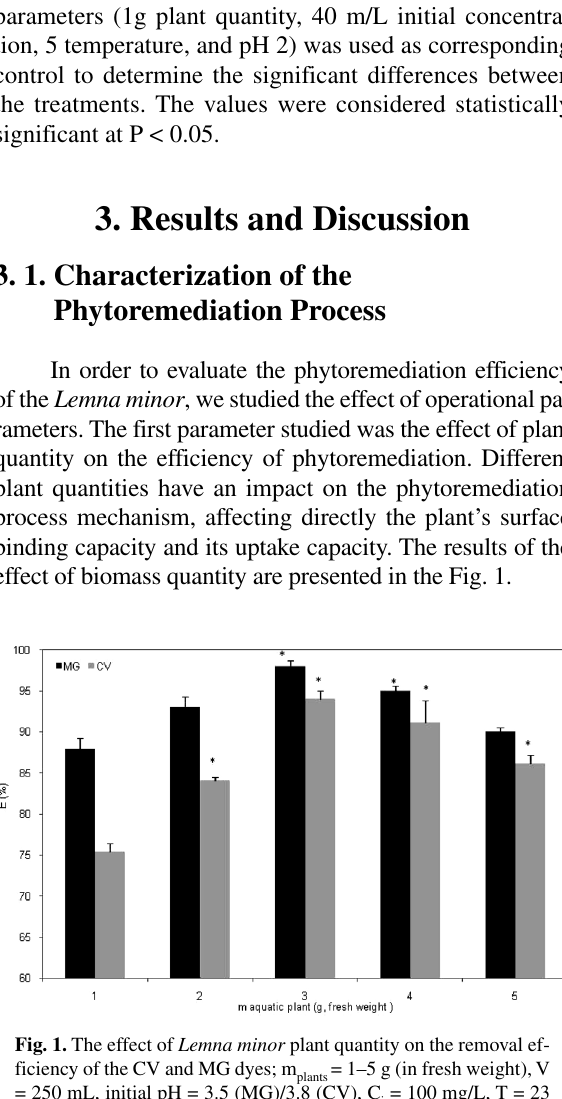
= 1–5 g (in fresh weight), V plants = 100 mg/L, T = 23 i